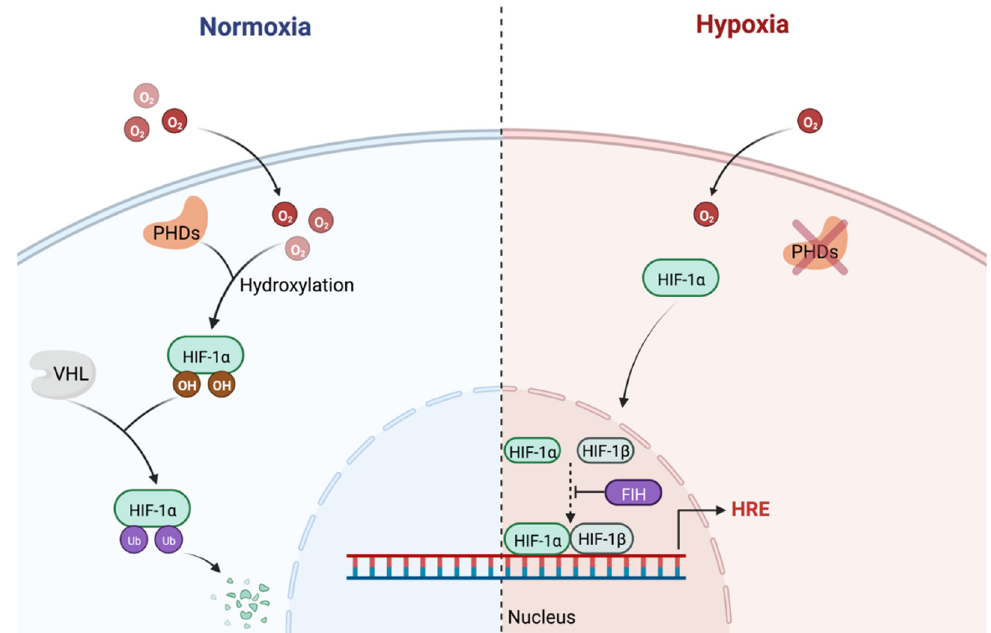
Figure 1. The HIF degradation pathway. Under normoxic conditions, HIF-1α undergoes hydroxyla- tion via PHDs which require oxygen. This hydroxylation allows HIF to be preferentially recognised by the VHL protein which targets the protein for ubiquitylation-dependent proteasomal degrada- tion. In hypoxic environments, HIF-1α is not targeted for hydroxylation and degradation, therefore accumulates and is translocated into the nucleus. Once in the nucleus, it can form a heterodimer with HIF-1β which binds to the hypoxia response elements (HRE) on the target genes to initiate their transcription. Figure created with BioRender.com (accessed on 13 July 2022).